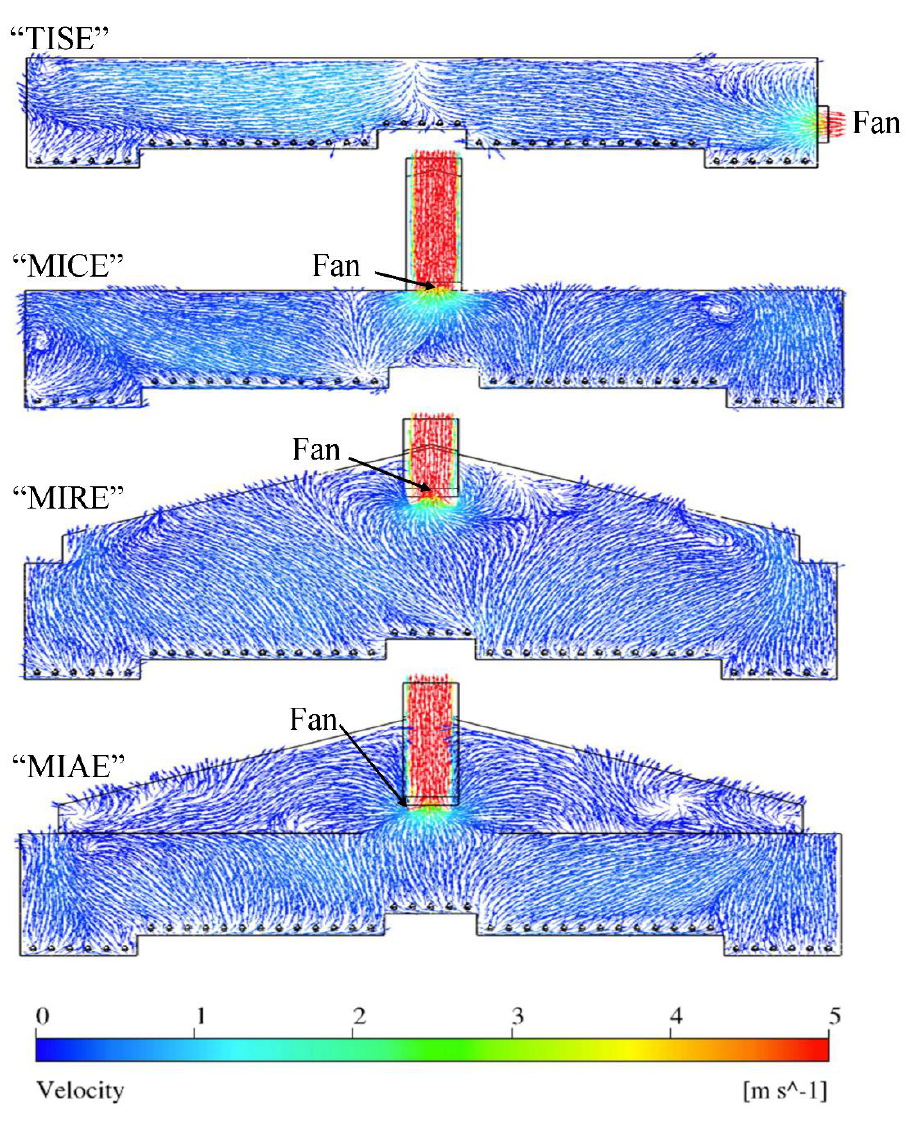
Figure 8. Indoor air velocity vector contours at Plane F of four models.